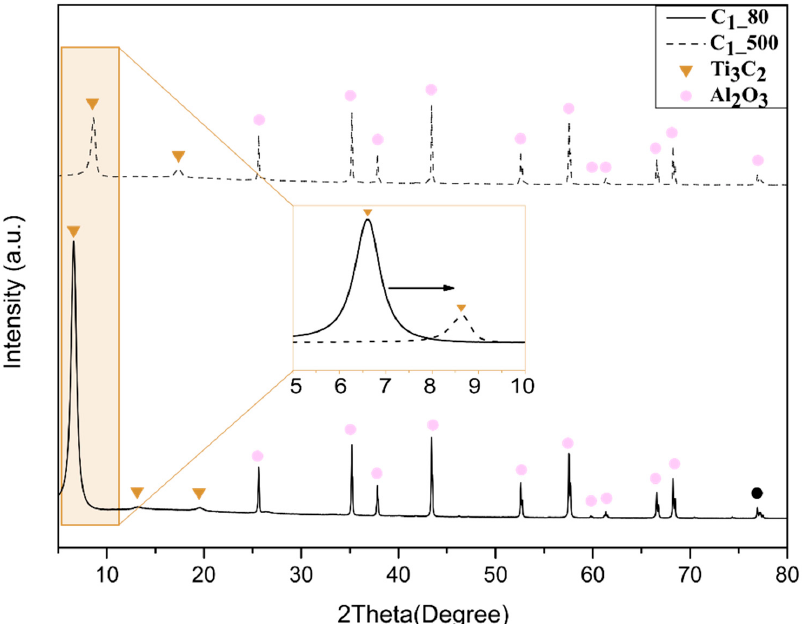
Figure 3. XRD patterns of Al 2 O 3 substrates coated with Ti 3 C 2 by dip coating using suspension C 1 treated at 80 °C under vacuum and 500 °C under H 2 /Ar atmosphere.